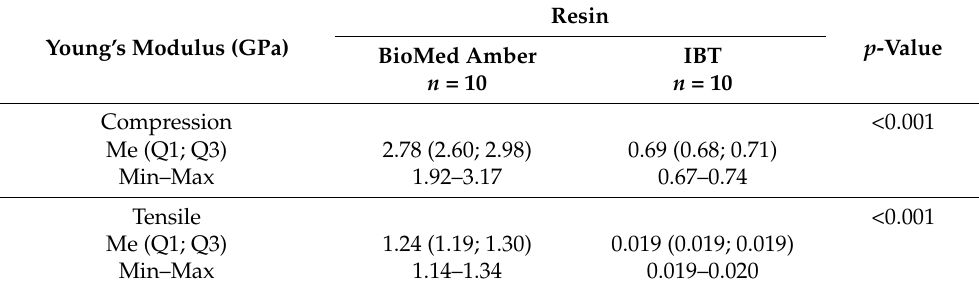
Table 2. Basic statistical data of the mechanical properties of the two dental resins.